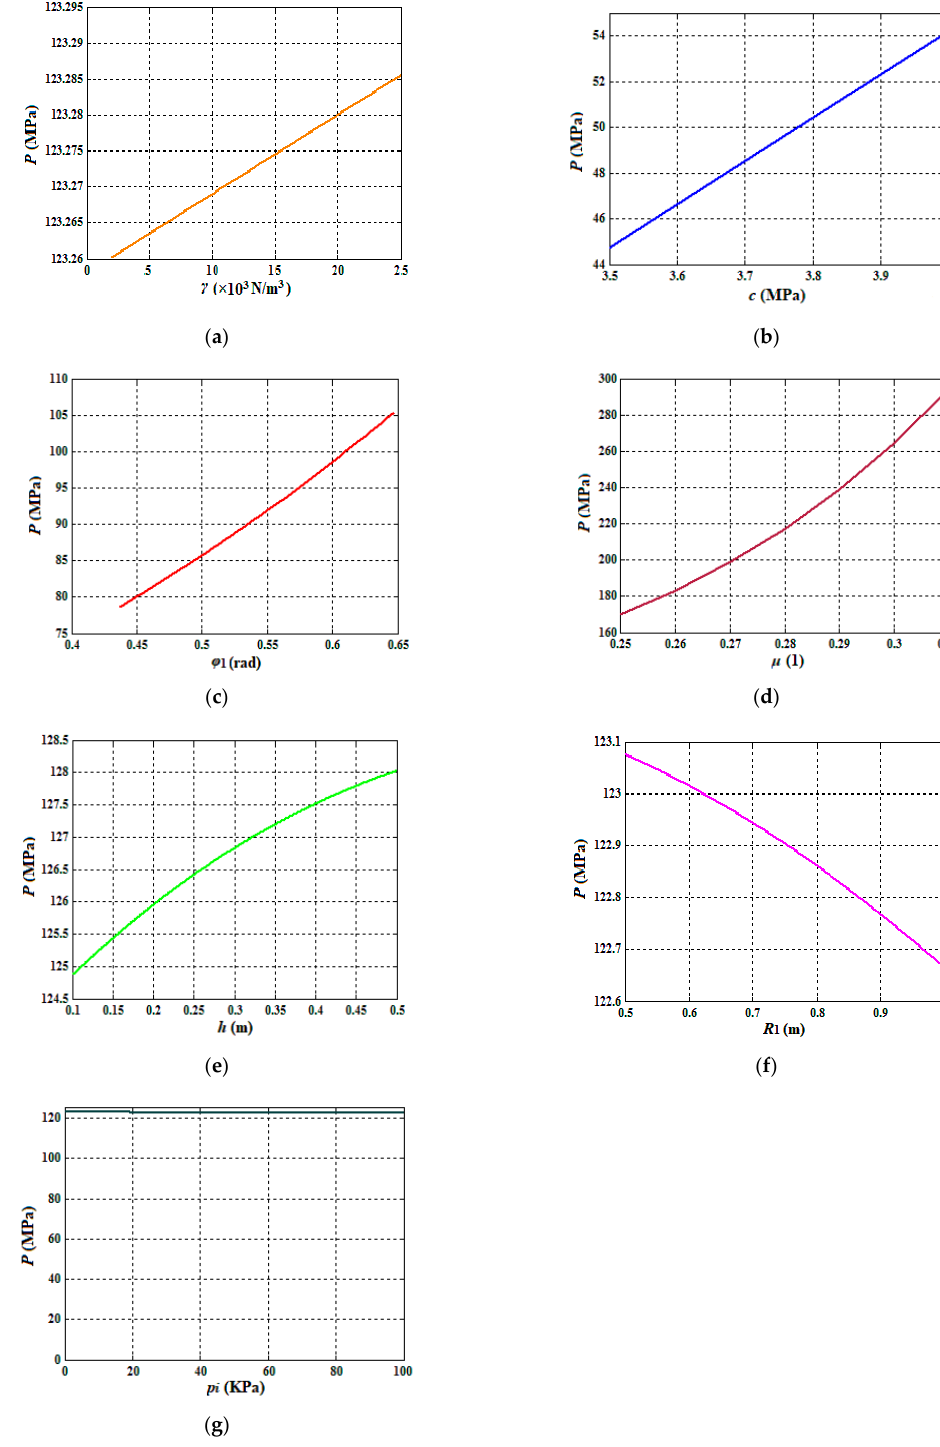
Figure 11. The curves of the bear capacity of limestone strata caused by a single influencing factor. ( a ) The range of γ value is from 2 kN/m 3 to 4 MPa. ( b ) The range of c value is from 3.5 MPa to 25 kN/m 3 . ( c ) The range of ϕ 1 value is from 0.43 rad to 0.63 rad ( d ) The range of µ value is from 0.25 to 0.31. ( e ) The range of h value is from 0.1 m to 0.5 m ( f ) The range of R 1 value is from 0.5 m to 1.0 m. ( g ) The range of p i value is from 0 kPa to 100